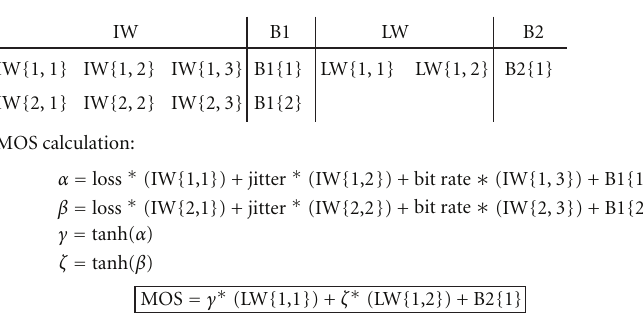
Figure 10: MOS calculation using neural network model parameters. Table 6: TFIFO model parameters showing weights and biases for QCIF and QVGA resolutions. Params. QCIF MPEG-2